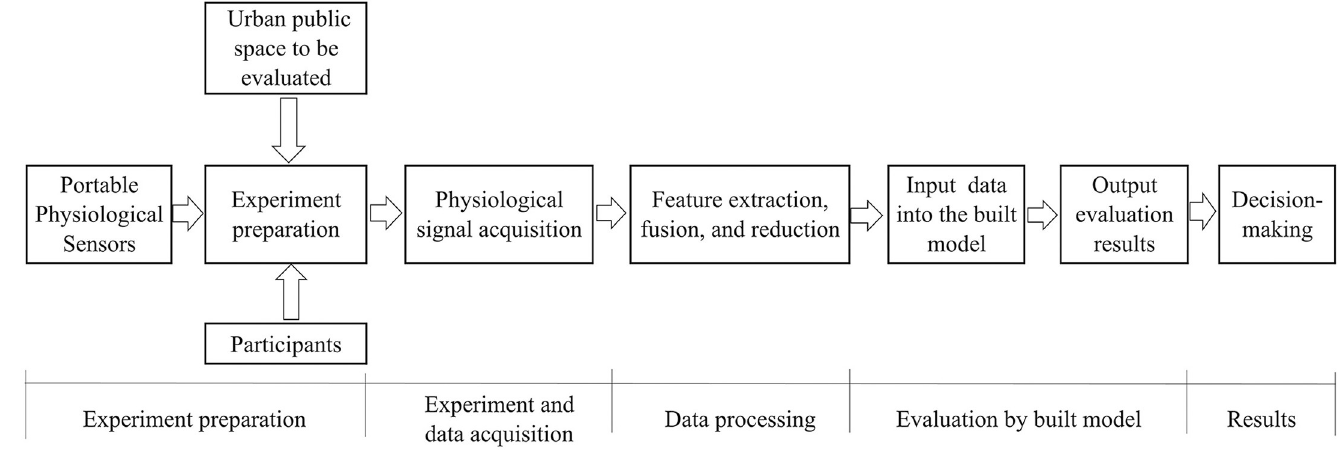
Fig 12. Emotional quality evaluation process of urban built public